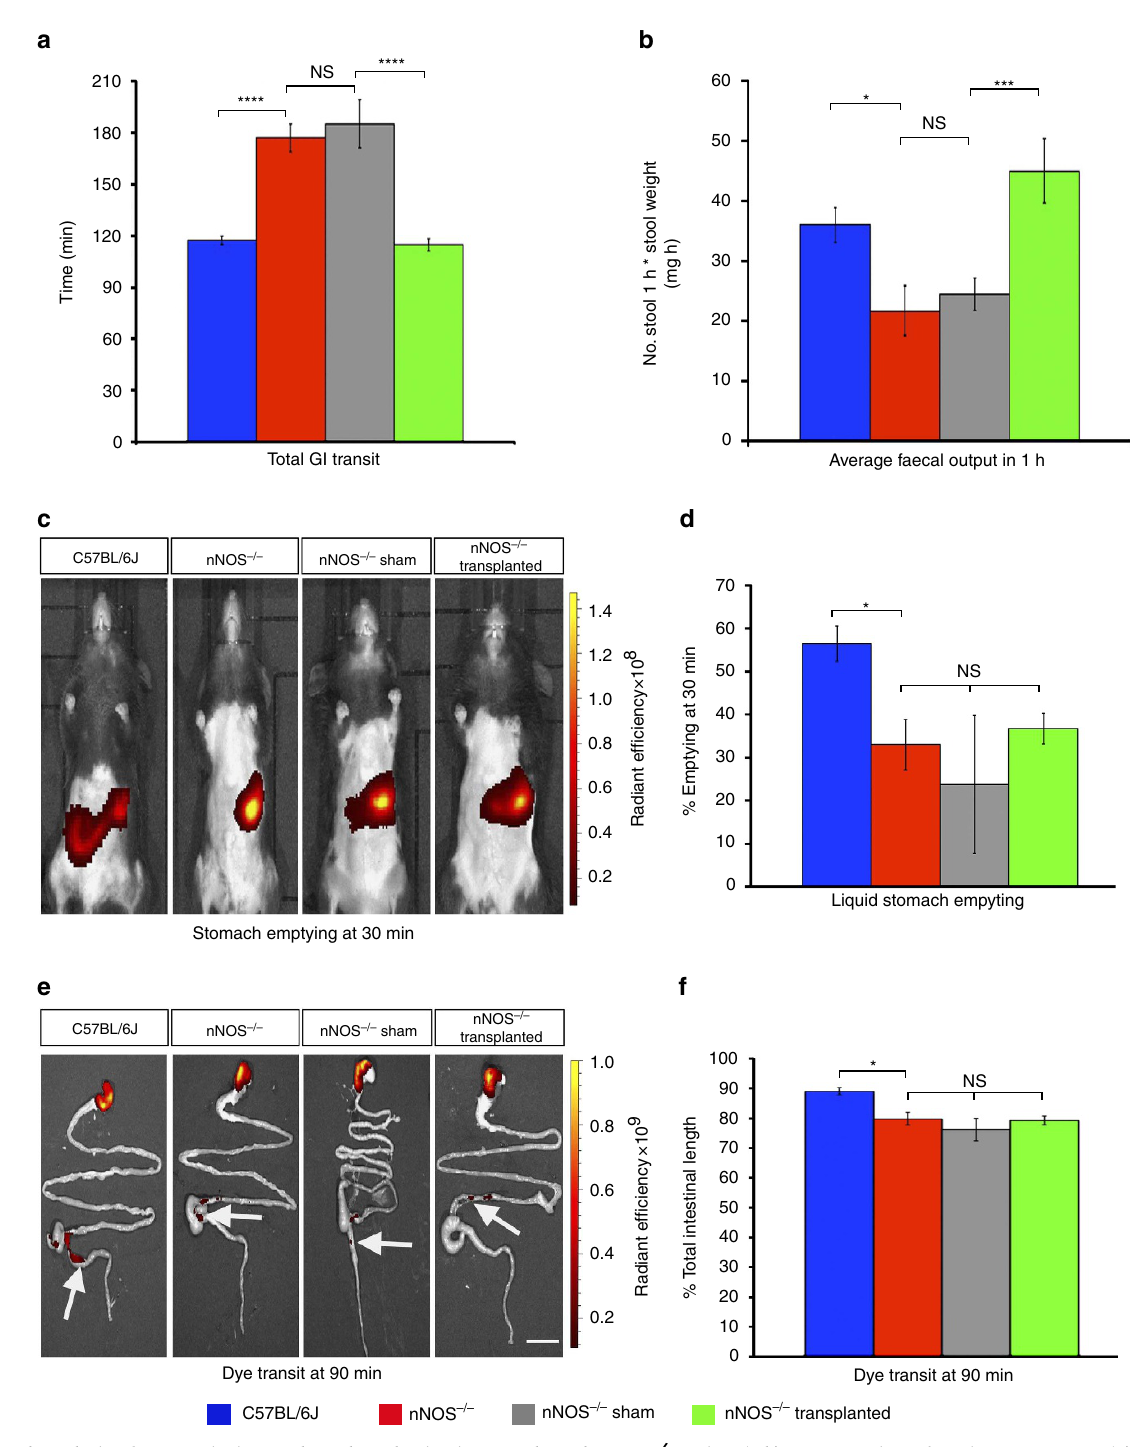
Figure 5 | Analysis of GI transit time and stool production in transplanted nNOS (cid:2) / (cid:2) mice. ( a , b ) Summary data of total GI transit time ( a ) measured after oral gavage of dye, and faecal output ( b ), 4 weeks after transplantation in C57BL/6J (blue bars), non-transplanted nNOS (cid:2) / (cid:2) (red bars), sham- operated nNOS (cid:2) / (cid:2) (grey bars) and transplanted nNOS (cid:2) / (cid:2) (green bars) mice. n ¼ 5 for each group, **** P r 0.0001, *** P r 0.001, ** P r 0.01, * P r 0.05 by Student’s t -test. ( c ) Representative in vivo fluorescent images 30min after gavage of a fluorescent marker. ( d ) Quantification of percentage stomach emptying at 30min in C57BL/6J (blue bars), nNOS (cid:2) / (cid:2) (red bars), sham-operated nNOS (cid:2) / (cid:2) (grey bars) and transplanted nNOS (cid:2) / (cid:2) (green bars) mice. n ¼ 3 for each group. * P r 0.05 by Student’s t -test. ( e ) Example fluorescent images of the C57BL/6J, nNOS (cid:2) / (cid:2) , sham-operated nNOS (cid:2) / (cid:2) and transplanted nNOS (cid:2) / (cid:2) intestine ex vivo , 90min after gavage of a fluorescent marker. ( f ) Summary data of dye transit at 90min in C57BL/6J (blue bars), nNOS (cid:2) / (cid:2) (red bars), sham-operated nNOS (cid:2) / (cid:2) (grey bars) and transplanted nNOS (cid:2) / (cid:2) (green bars) mice. n ¼ 3 for each group. * P r 0.05 by Student’s t -test. Error bars represent mean ± s.e.m. in all